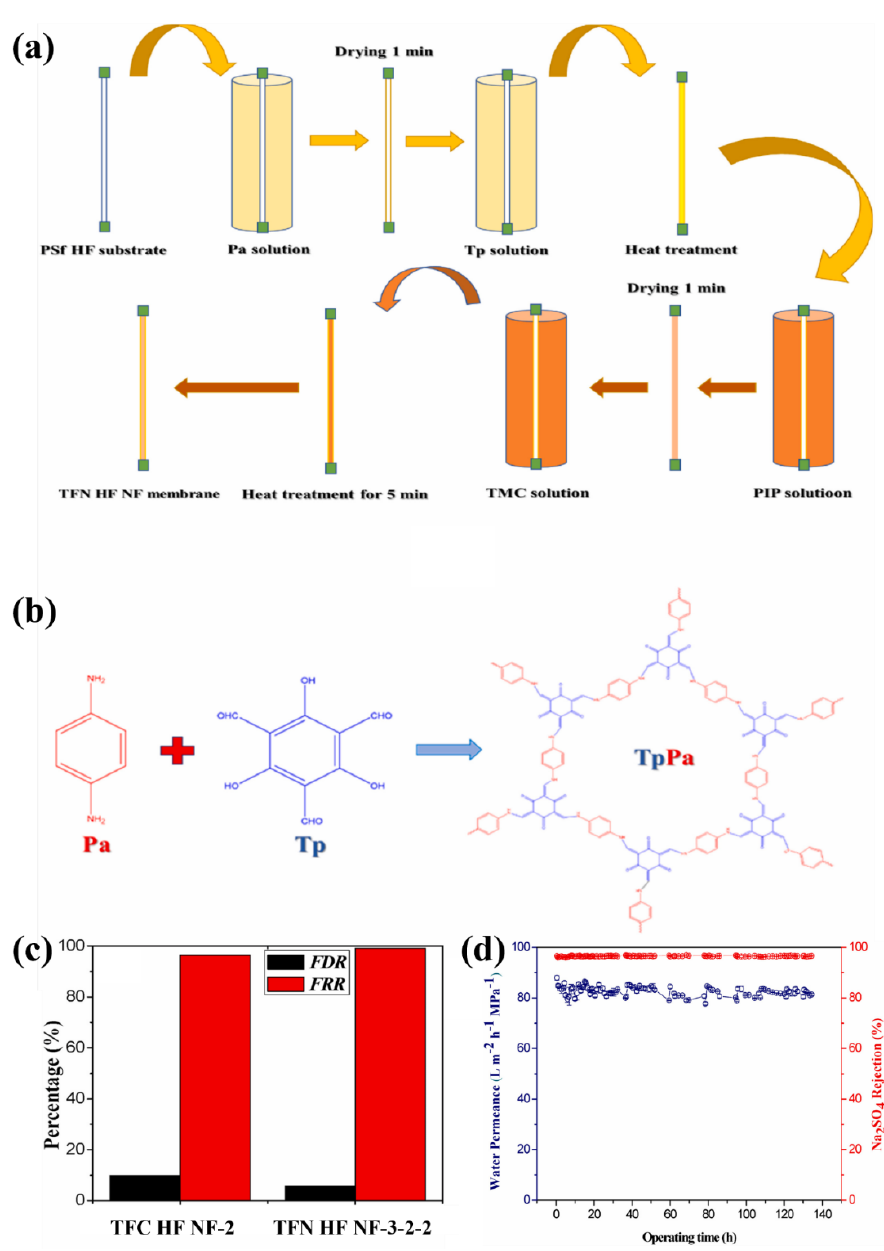
Figure 6. Schematic of ( a ) the IP process for preparing TFN HF NF membrane and ( b ) mechanism of the COF interlayer formation; ( c ) flux reduction rate (FDR) and flux recovery rate (FRR) of TFC and TFNi membranes; ( d ) long-term performance test of TFNi membrane, reproduced with permission from Jiang et al. [91], with copyright permission from © 2021